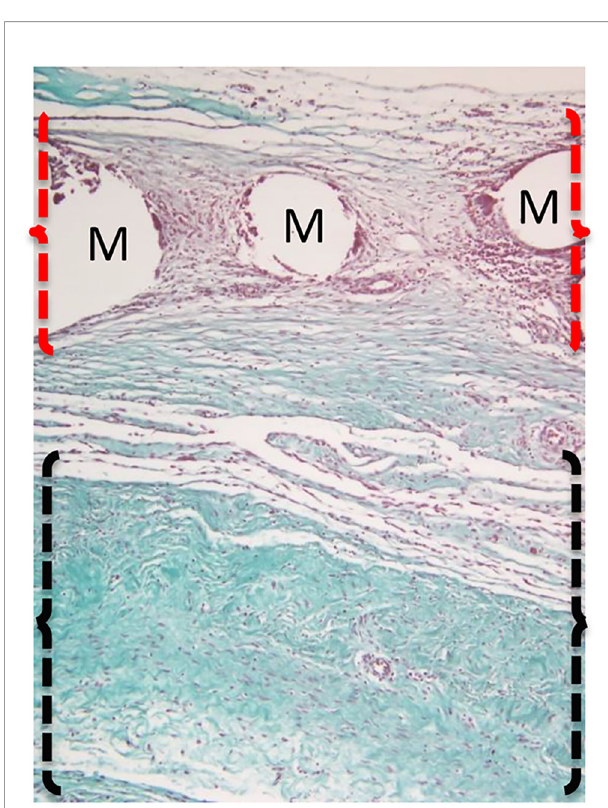
FIGURE 4 | Representative image of a surgically implanted mesh and its surrounding tissue. The assessment of cellular characteristics was performed in the mesh (M) area (indicated by red brackets), whereas the connective tissue was evaluated in the area below the mesh (indicated by black brackets). The image represents a tissue sample stained with Masson ’ s trichome stain.